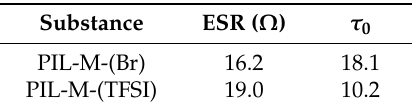
Figure 8. Bode plot of ( a ) MBIB and PIL-M-(Br) and ( b ) MBIT and PIL-M-(TFSI)-based supercapacitors. Table 3. EIS data of PIL-M-(Br)- and PIL-M-(TFSI)-based